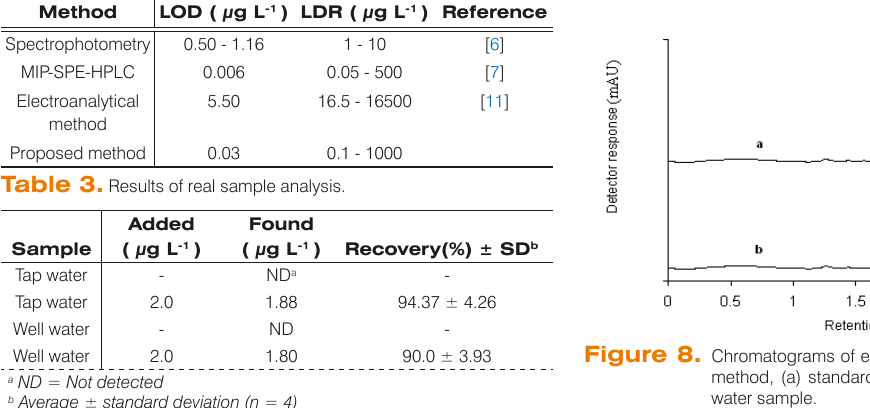
Table 3. Typical chromatograms of real sample and PCP standard solution are presented in Fig. 8.